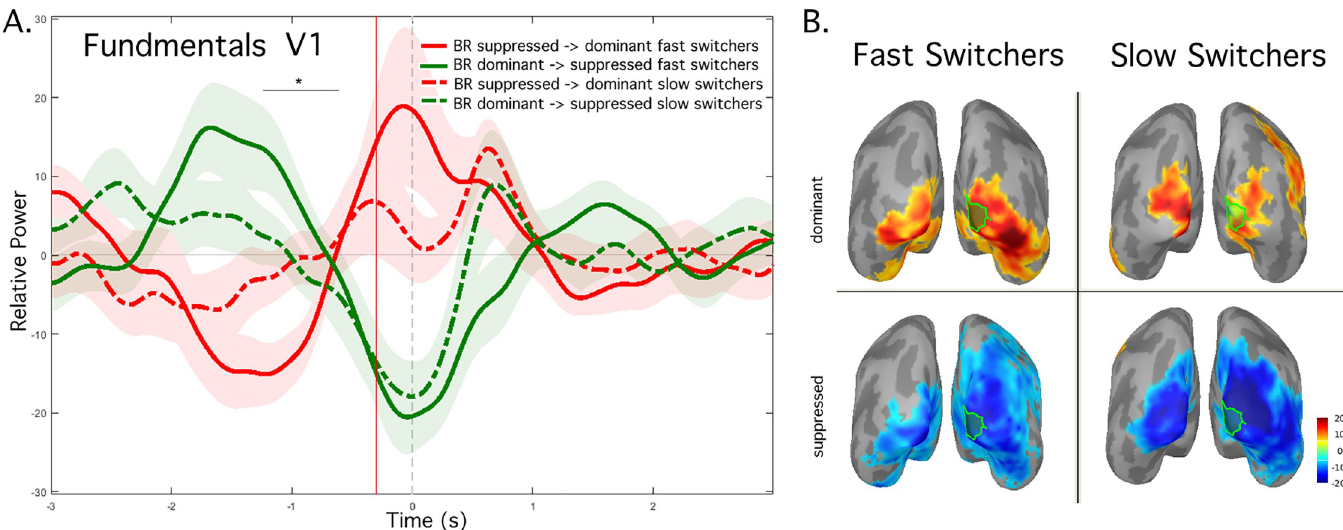
Fig 3. Dominant vs. suppressed fundamental frequency power difference for BR: Fast vs. Slow Switchers, group-average (n = 5 in each group). A. Power fluctuations over time extracted from visual area right V1 for the condition BR for Fast Switchers dominant power (red) and suppressed power (green) and Slow Switchers cortical responses at dominant (dashed red) and suppressed (dashed green) frequencies. Pale color fill indicates the standard error of the mean (SEM). Gray horizontal line with asterisks indicates the brief period when dominant minus suppressed power differed for Fast and Slow Switchers (see text) B. Dominant (top row) and suppressed (bottom row) response maps extracted at -300 ms from button press are visualized on the inflated cortical surface comparing Fast Switchers (left column) and Slow Switchers (right column). Green outlines indicate left and right V1 from probabilistic atlas.